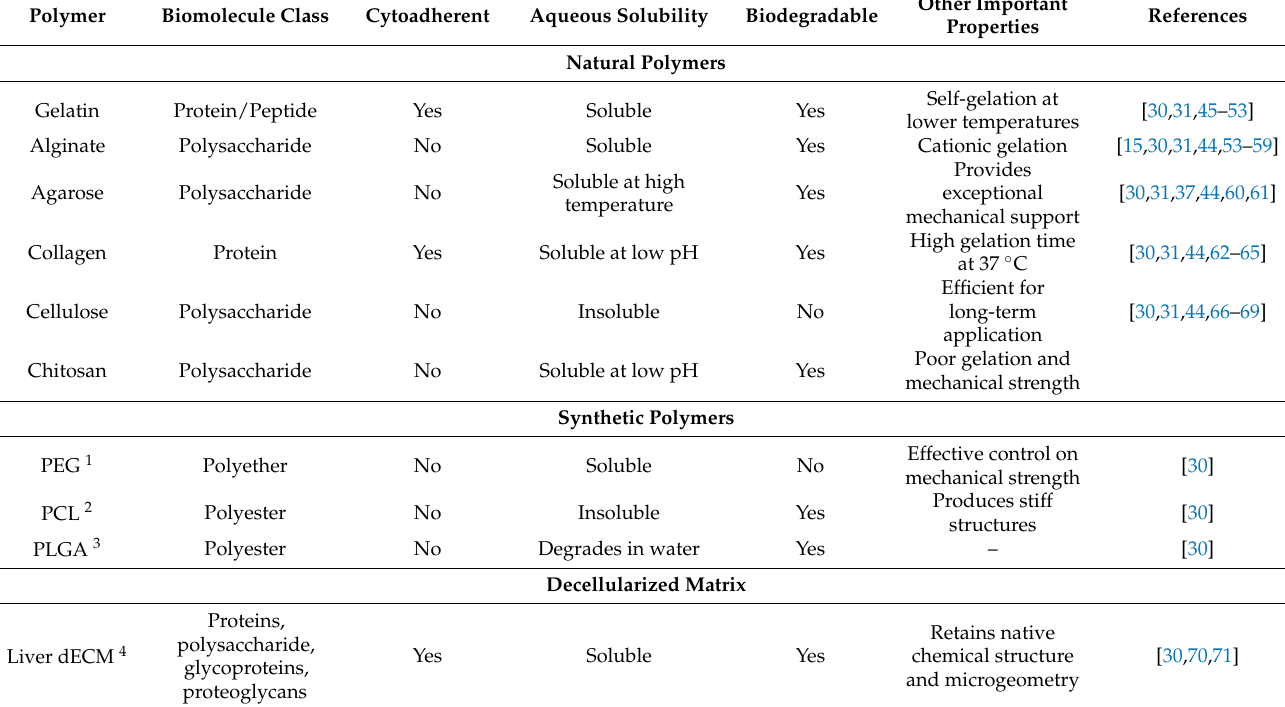
Table 1. Major properties of different polymers used as bioinks for 3D bioprinting of hepatic structures.